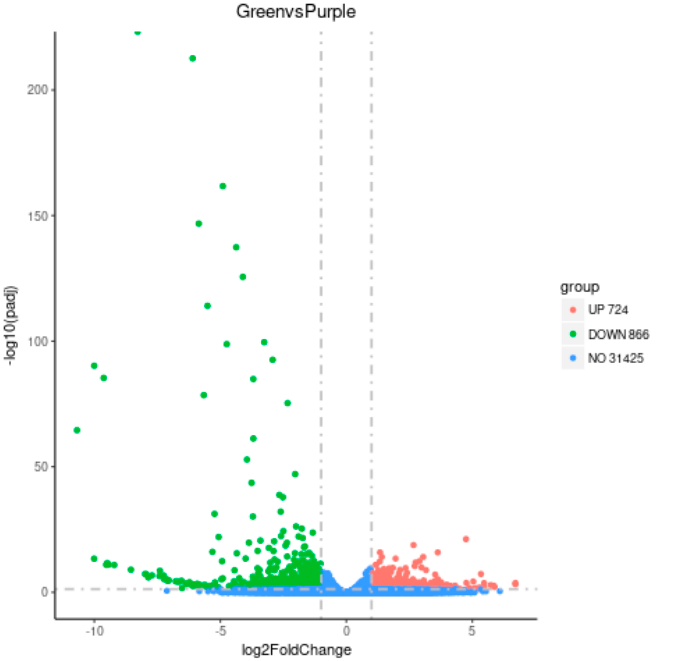
Figure 3. Identification of DEGs between purple non-heading Chinese cabbage and its green mu- tant.